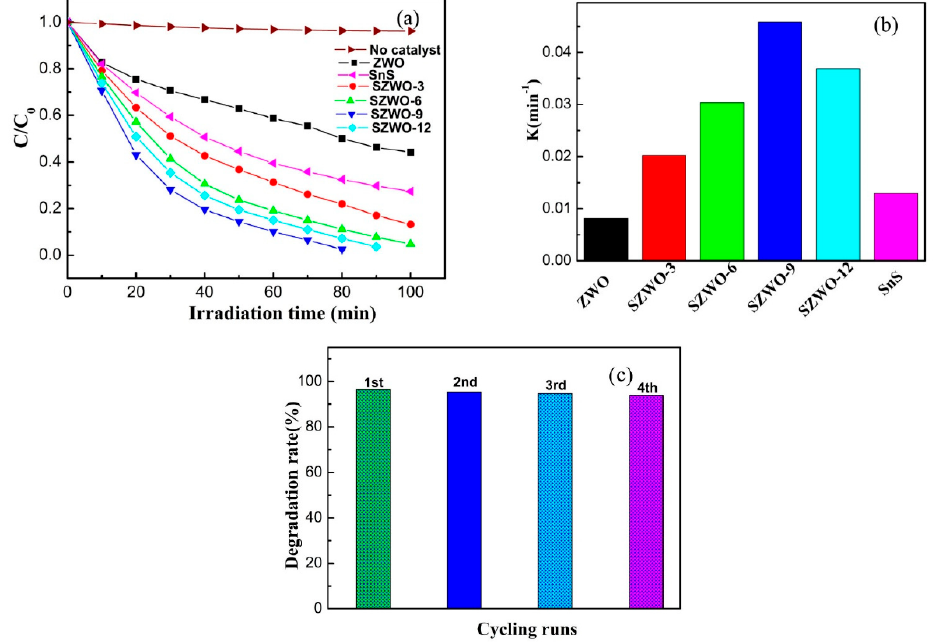
Figure 7. ( a ) the photodegradation performance of RhB solution, ( b ) the corresponding apparent reaction rate constant, ( c ) cycling performance of the photodegradation of RhB solution over the SZWO-9 sample.